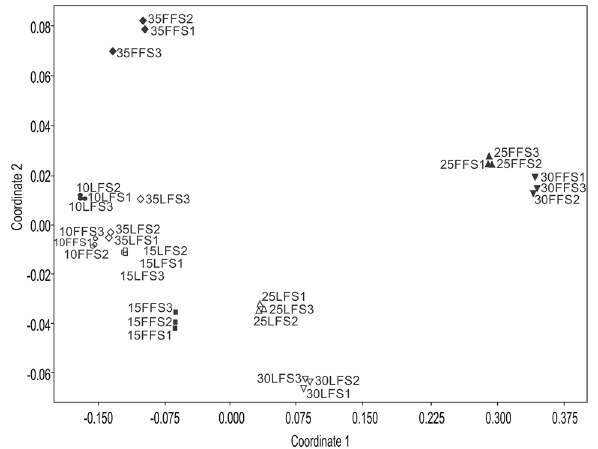
Figure 3. Non-metric multidimensional scaling (nMDS) (Bray–Curtis similarity) of log-transformed free amino acid content in two types of ensilages ((FFS and LFS) at different days of fermentation (DoF).